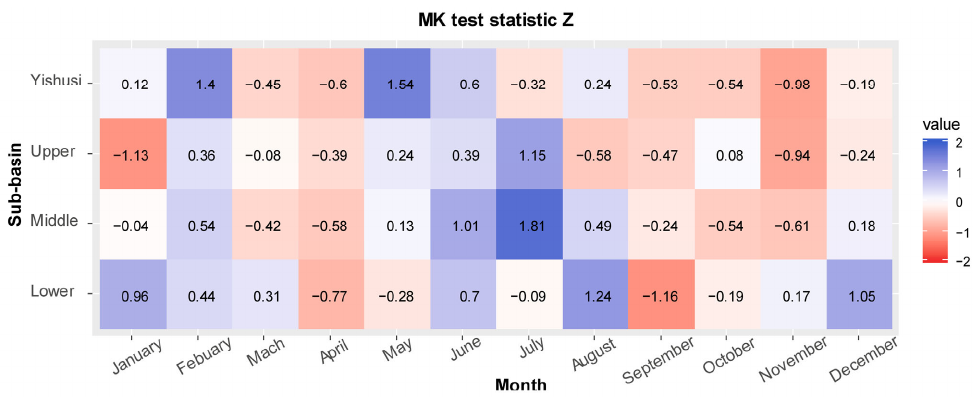
Figure 3. MK test results of monthly MSDI series in four sub ‐ regions of the HRB.